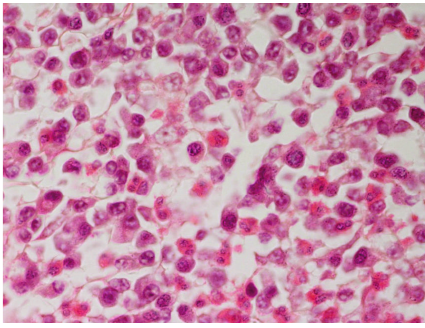
Figure 4: Foreign body granuloma in the cerebrum with chronic inflammation characterized by infiltration of macrophages, plasma cells, lymphocytes and eosinophils, large number of foreign body giant cells, and the central liquefactive necrosis, surrounded by a fibrous tissue capsule. H&E × 100.